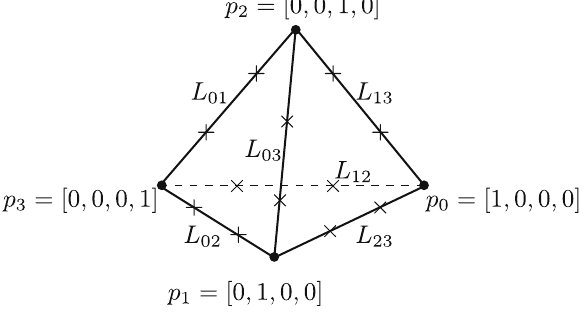
Figure 1: Double lines and triple points in